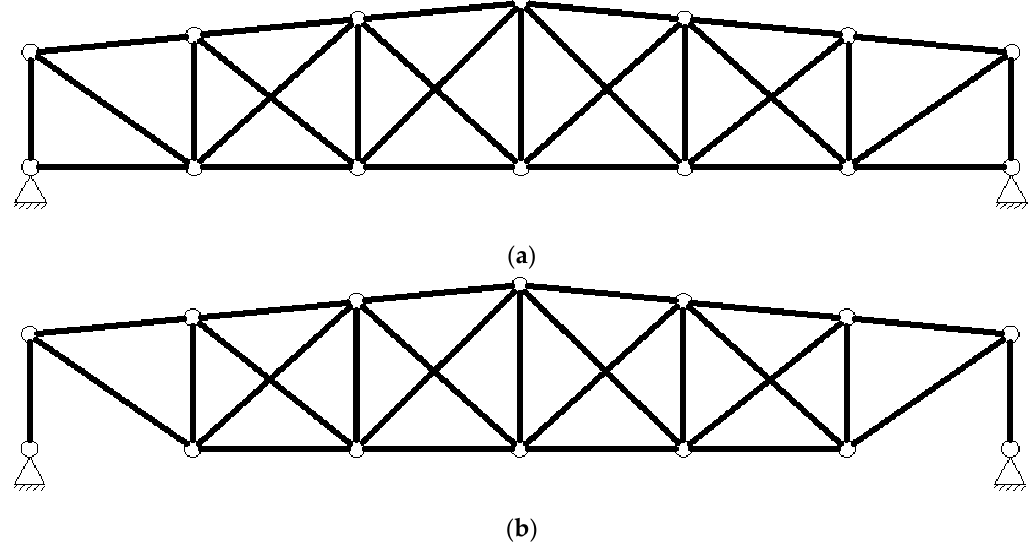
Figure 5. Change in the static scheme of a truss with the blockade of free thermal deformations along with the fire duration: ( a ) t fi = 4.12 min (247 s) and ( b ) t fi = 5.75 min (345 s).